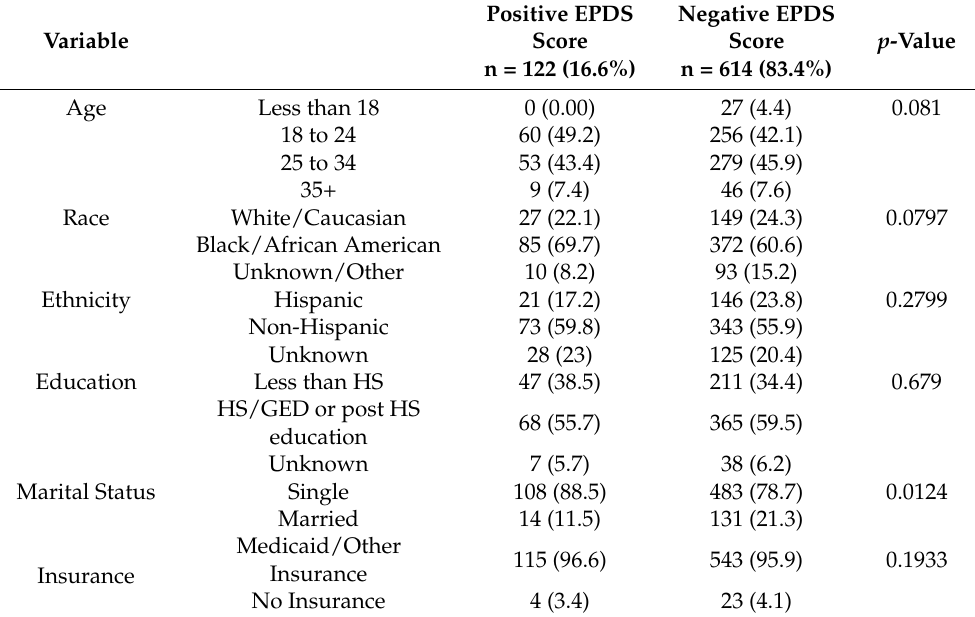
Table 1. Characteristics of Healthy Start participants, Tampa, Florida,